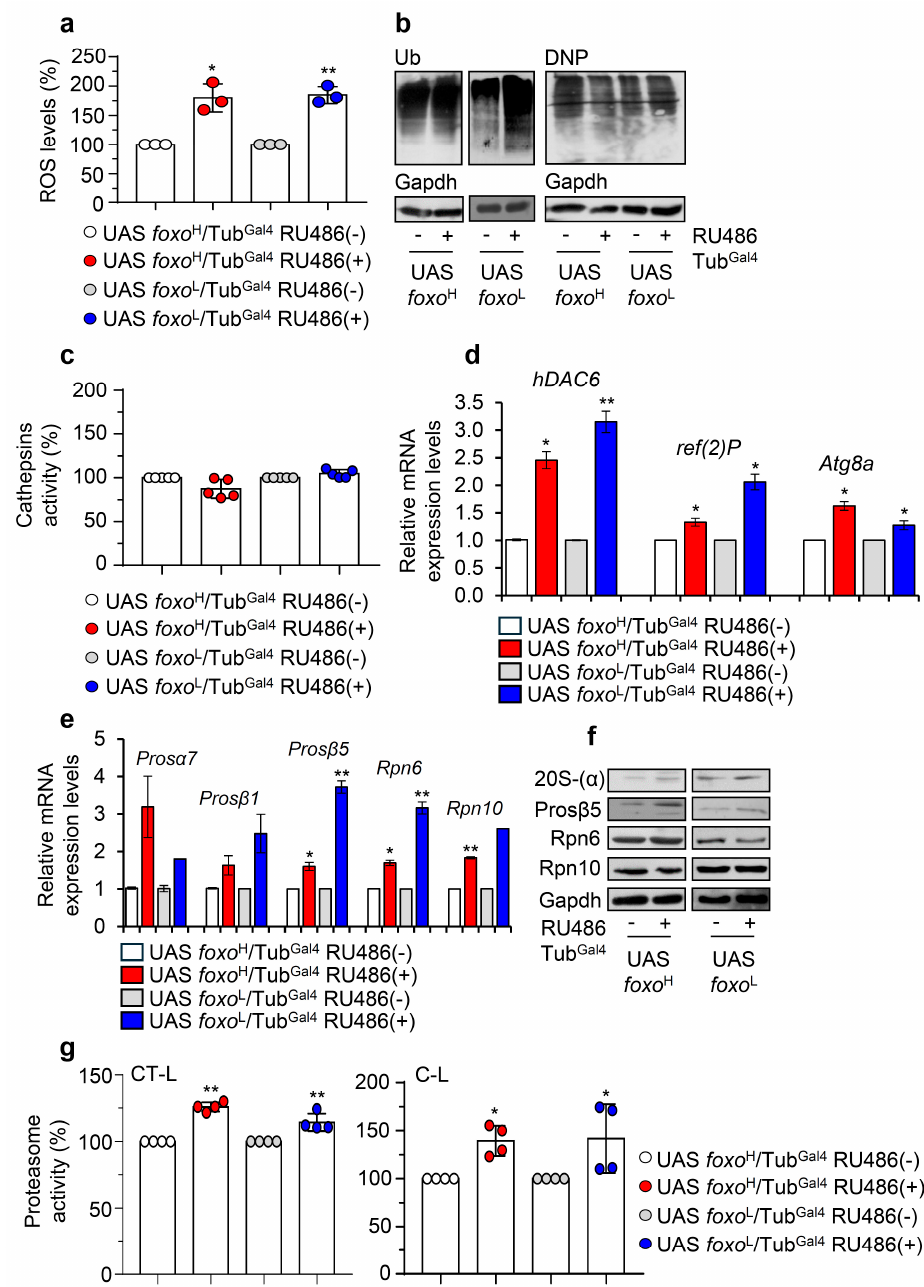
Figure 6. Ubiquitous foxo OE causes oxidative and proteome instability triggering proteasome activation. ( a ) ROS (%) levels in foxo overexpressing flies vs. controls. ( b ) Representative immunoblots of cellular ubiquitinated (Ub) and carbonylated (DNP) proteins in foxo overexpressing flies’ somatic tissues. ( c ) Cathepsins activity (%) in somatic tissues of foxo overexpressing flies. ( d ) Relative expression levels of autophagy-related ( hDAC6 , ref(2)P , Atg8a ) and ( e ) proteasomal ( Pros α 7 , Pros β 1 , Pros β 5 , Rpn6 , Rpn10 ) genes in shown foxo overexpressing transgenic flies’ somatic tissues. ( f ) Immunoblotting analyses showing expression of the 20S-( α ), Pros β 5, Rpn6, and Rpn10 proteasome subunits after inducible foxo OE in flies’ somatic tissues. ( g ) 26S CT-L and C-L proteasome activities (%) in tissues lysates of shown foxo overexpressing transgenic flies’ somatic tissues; transgenes were induced for 7 days in young Drosophila flies. In ( a , c , g ) control values were set to 100%. In ( b , f ), Gapdh was used as a loading control. In ( d , e ), gene expression was plotted vs. controls set to 1; the RpL32 gene expression was used as input reference. Bars, ± SD; n ≥ 2, 10 flies were used per experimental repeat; significant differences were calculated with unpaired t -test ( d , e ) or two-way ANOVA followed by Tukey’s multiple comparisons test ( a , c , g ), * p < 0.05, ** p <